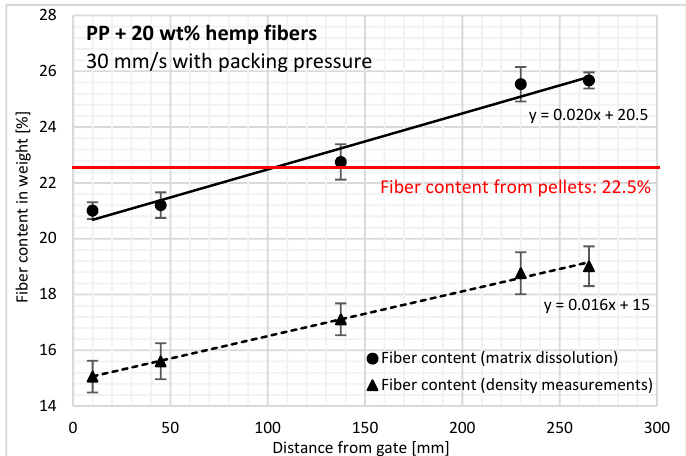
Figure 5. Hemp fiber content changes along the flow path for PP reinforced with hemp fibers using the fiber extraction method and density measurements. Error bars correspond to plus or minus the standard deviation.